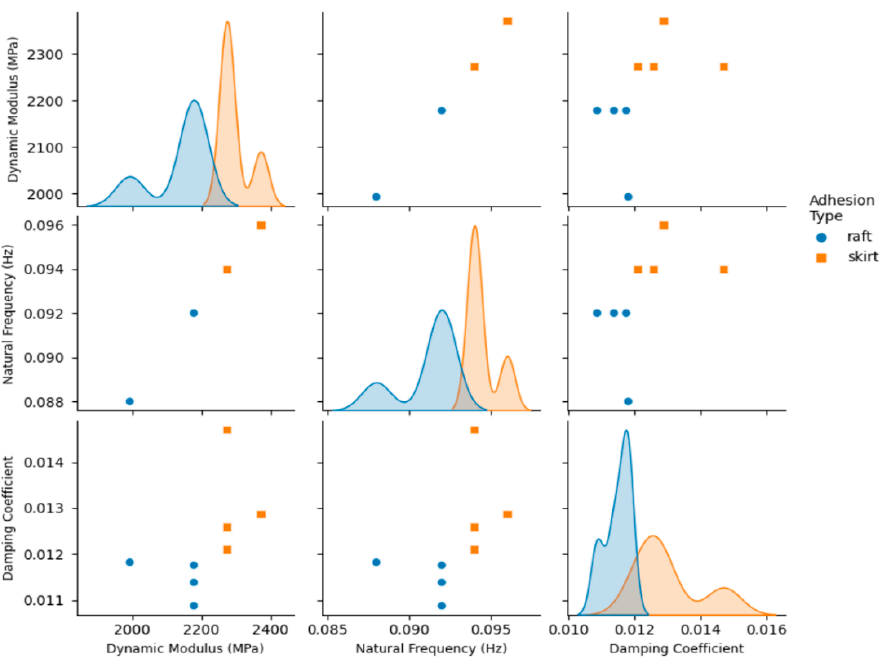
Figure 8. Pair plots of the modal analysis parameters obtained from the free-vibration tests of the 3D printed cantilevers. The variable of interest is the adhesion type (skirt and raft).